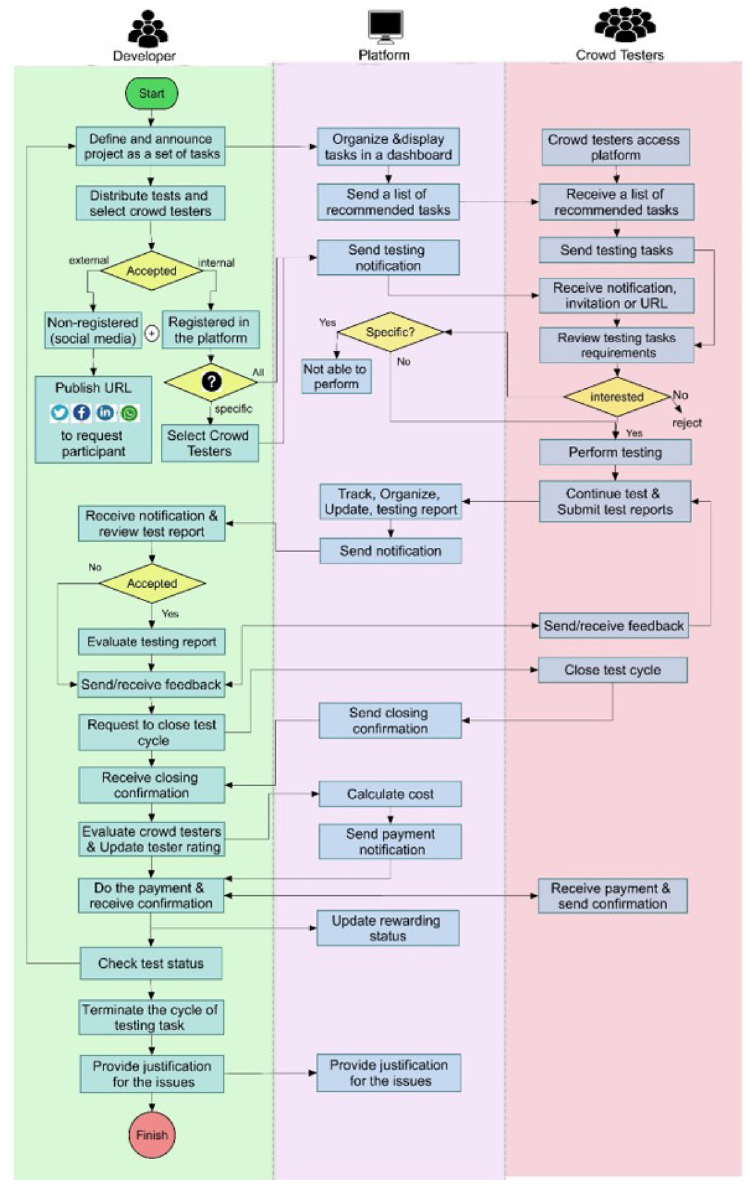
Figure 3. The proposed crowdsourced testing work fl ow